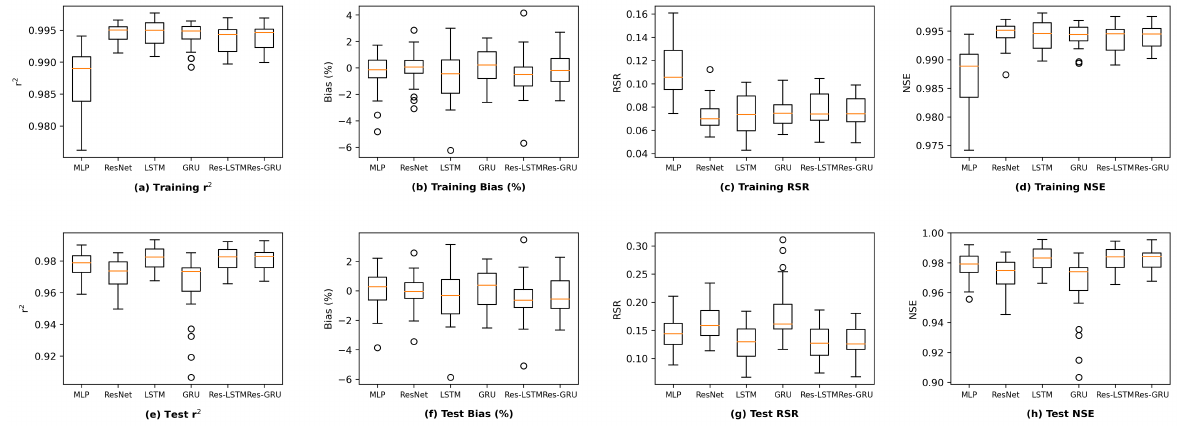
Figure 5. Comparison of six models on observed data at daily time